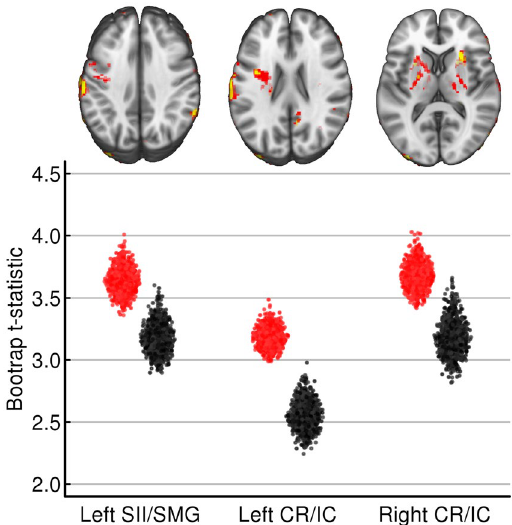
Figure 2. Well-matched and randomly matched case-control differences in Jacobian determinant/volumetric displacement. The top row of images shows the average t-score (thresholded with t ≥ 2.87 or the minimum t-score within the permutation corrected results in Fig. 1) across 1000 well matched (red clusters) and randomly matched (yellow clusters) case-control samples. Note that the extent of the effects are consistently smaller when a reading disability case was randomly matched with a control compared to when cases and controls were well- matched for brain volume and research site, even though the same 134 participants were examined in each set of analyses. The scatterplots show the distribution of 1000 t-scores pooled within the significant left SMG, Left CR/ IC, and Right CR/IC clusters from Fig. 1. Note the consistently higher average t-score for the well-matched case- control samples (red) compared to the randomly matched case-control samples (gray).